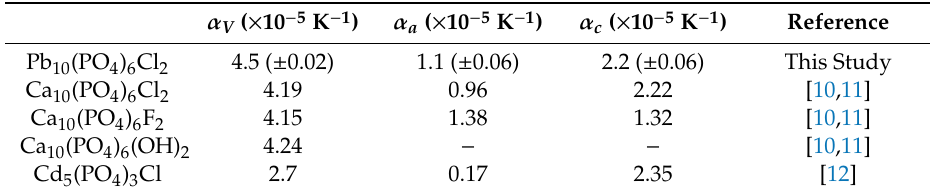
Table 2. Thermal expansion coe ffi cients based on linear fits of pyromorphite compared with other calcium or chlorine bearing apatites.